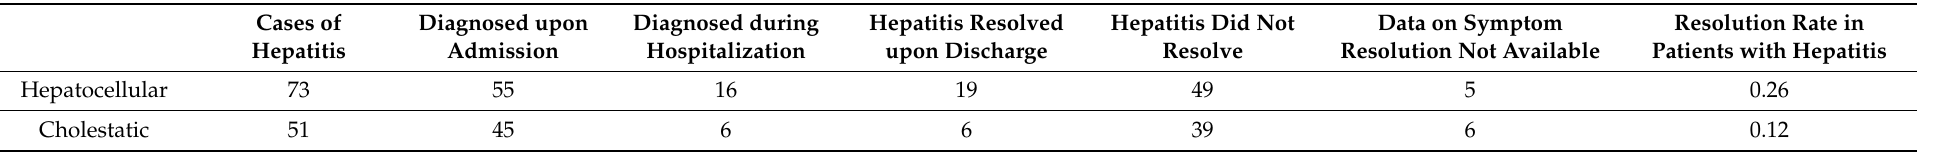
Table 3. Cases with elevated ALT, AST, ALP, and GGT together with parameter normalization towards the end of hospitalization, regardless of liver injury